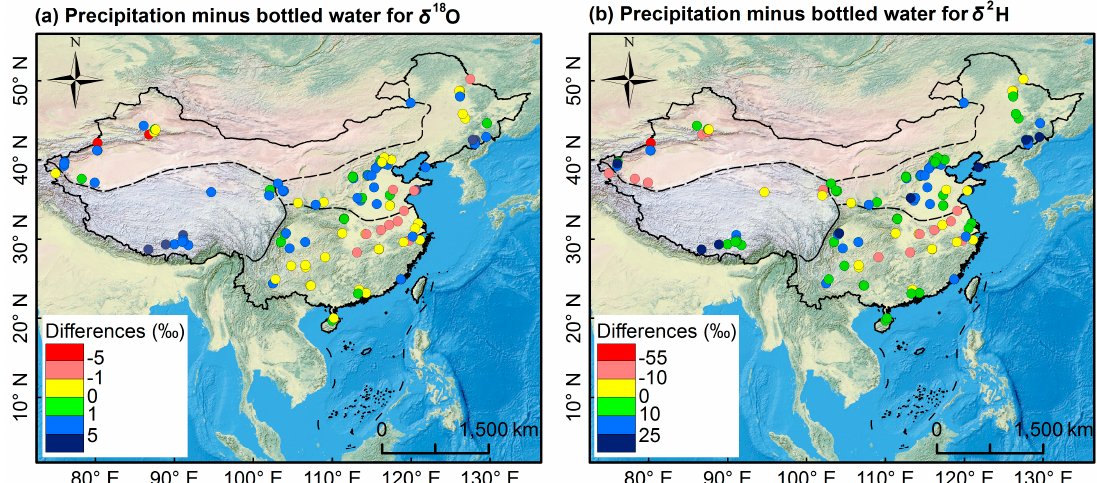
Figure 6. Differences between ( a ) δ 18 O values and ( b ) δ 2 H values of precipitation and bottled water samples. Sub-region boundaries and base map as in Figure 1.